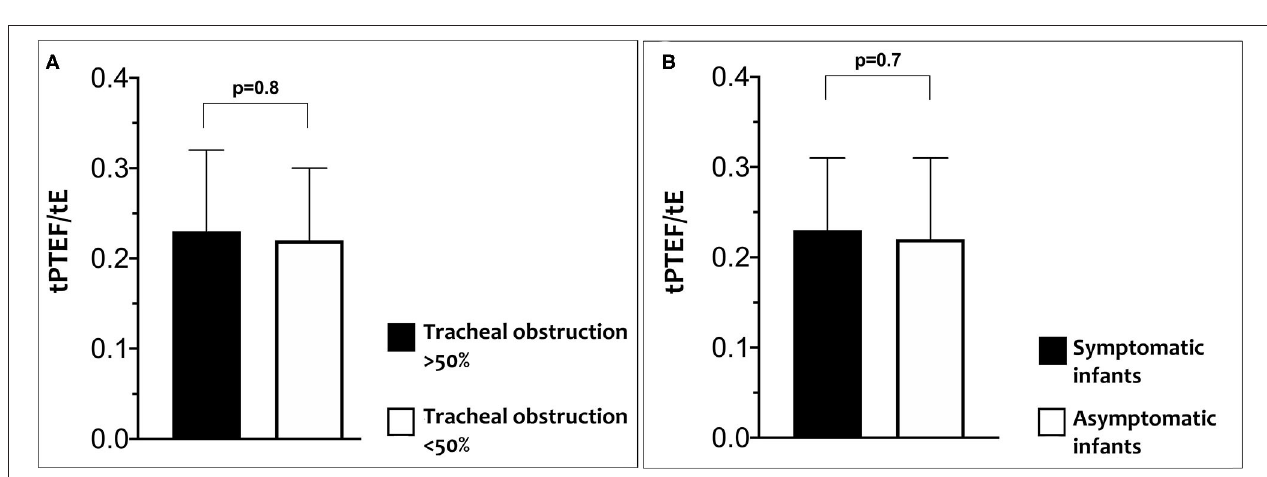
FIGURE 2 | Differences in tPTEF/tE according to percentage of tracheal obstruction (A) and in tPTEF/tE according to related symptoms (B)